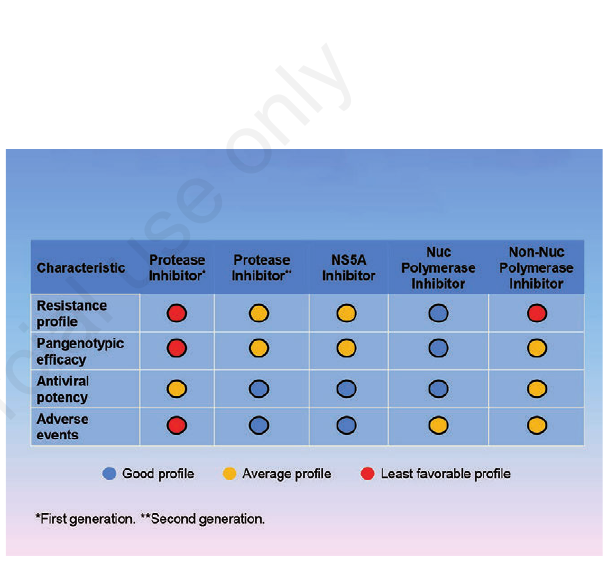
Figure 16. Not all direct-acting antivirals are created